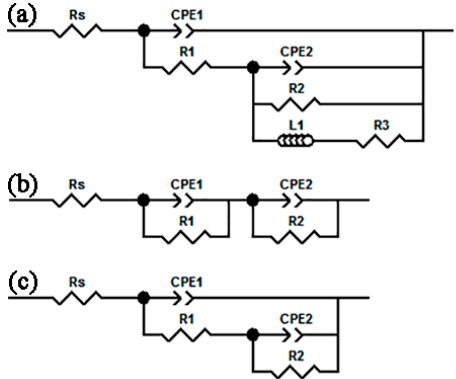
Figure 6. Electrochemical impedance spectroscopy and fitting results of the substrate, and the HA- and the MAO-treated 7050 Al alloy in 3.5 wt % NaCl solution. ( a ) Phase angle; ( b ) Impedance modulus.